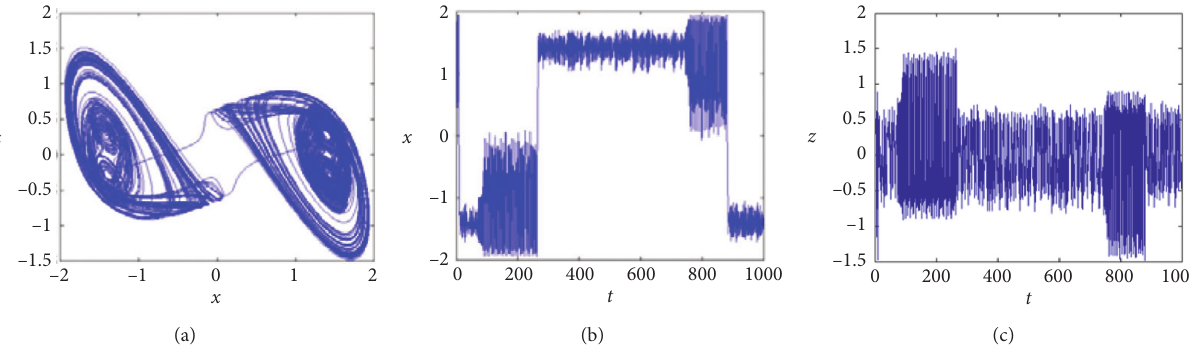
Figure 10: The transient transition behaviors of system (3). (a) A phase diagram of six-scroll hidden chaotic attractors. (b) Time-domain waveform of the variable ( x ). (c) Time-domain waveform of the variable z .